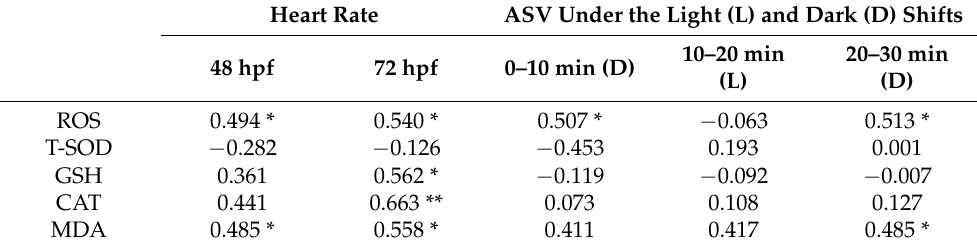
Table 2. Spearman’s correlation between the oxidative stress-related biomarkers and the heart rate or average swimming velocity (ASV) of zebrafish ( Danio rerio ) 1